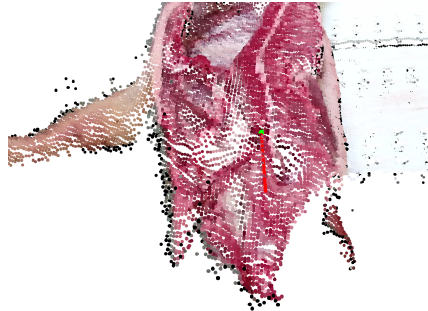
Figure 17. The 5-DoF cutting plane for head cutting illustrated by a green dot and a red normal vector.